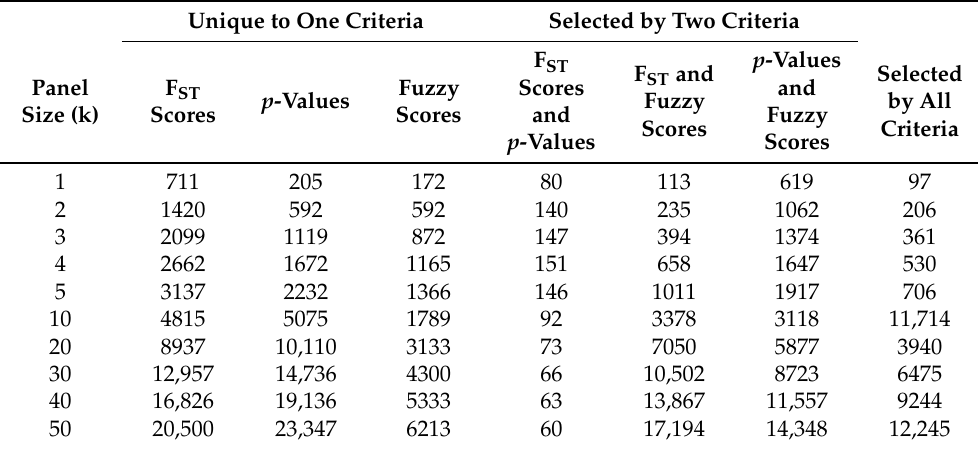
Table 9. The number of SNPs unique to one criteria or shared across two or more criteria for a genetic architecture of 1 k causative variants distributed across all chromosomes. Unique to One Criteria Selected by Two Criteria